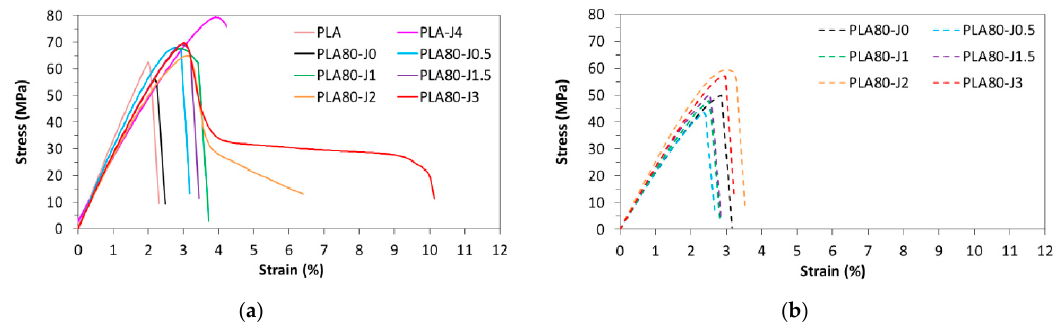
Figure 8. Stress–strain curves of injected PLA, PLA-J4 and PLA80-Jx blends ( a ) and FDM printed PLA80-Jx blends ( b ). PLA80-Jx blends ( b